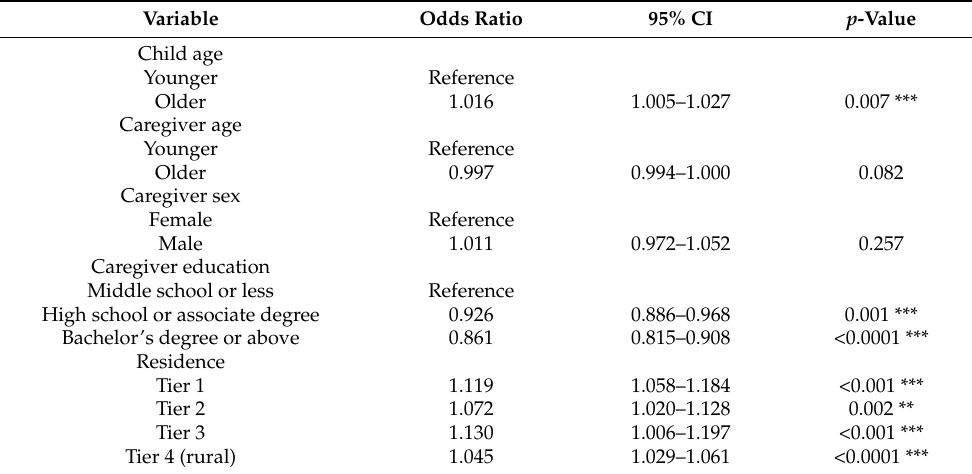
Table 5. Predictors of caregiver use of non-prescribed antibiotics before physician